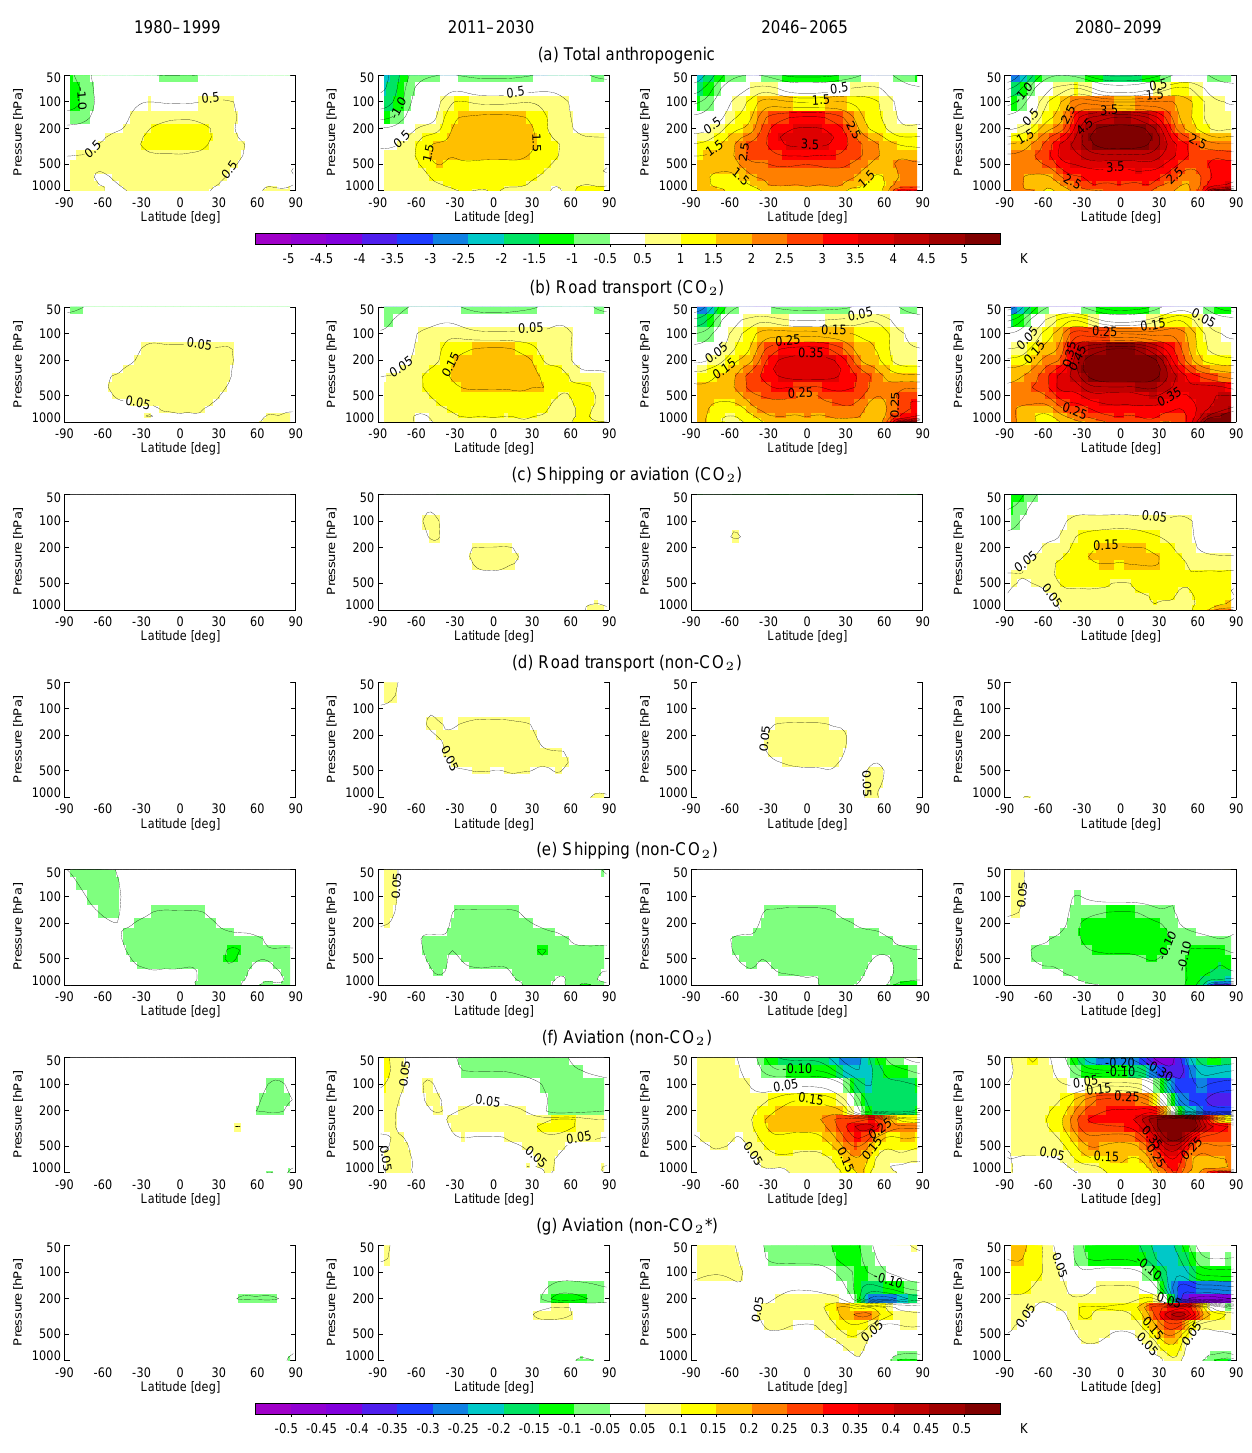
Fig. 15. Impact on annual zonal mean temperature profile in the periods 1980–1999, 2011–2030, 2046–2065 and 2080–2099. The order of the plots is as in Fig. 10. Notice that the contour intervals are 5 times larger for the total anthropogenic perturbation (a) .